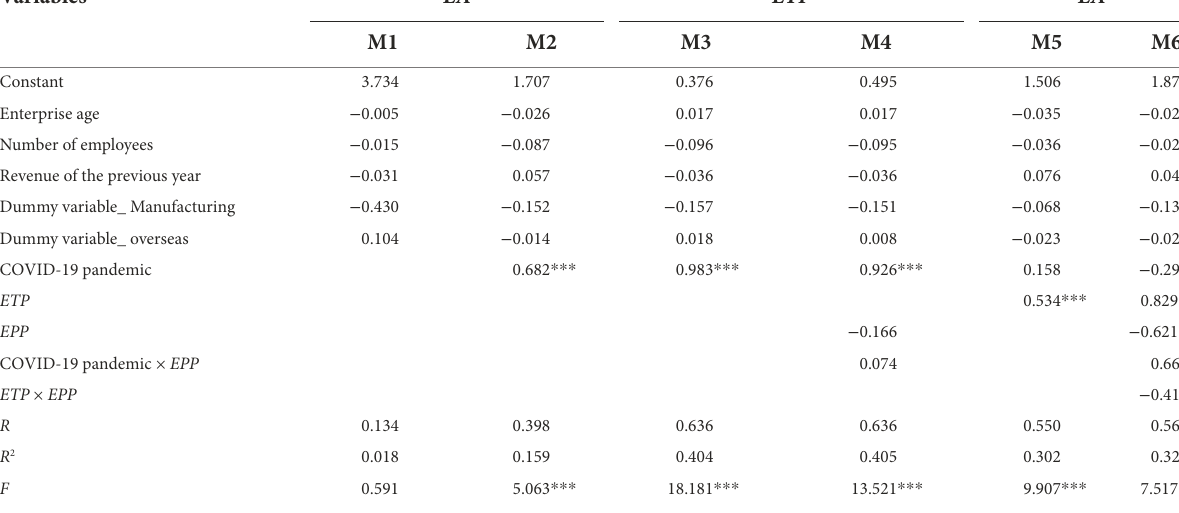
TABLE 5 Regression results of COVID-19 pandemic on EA